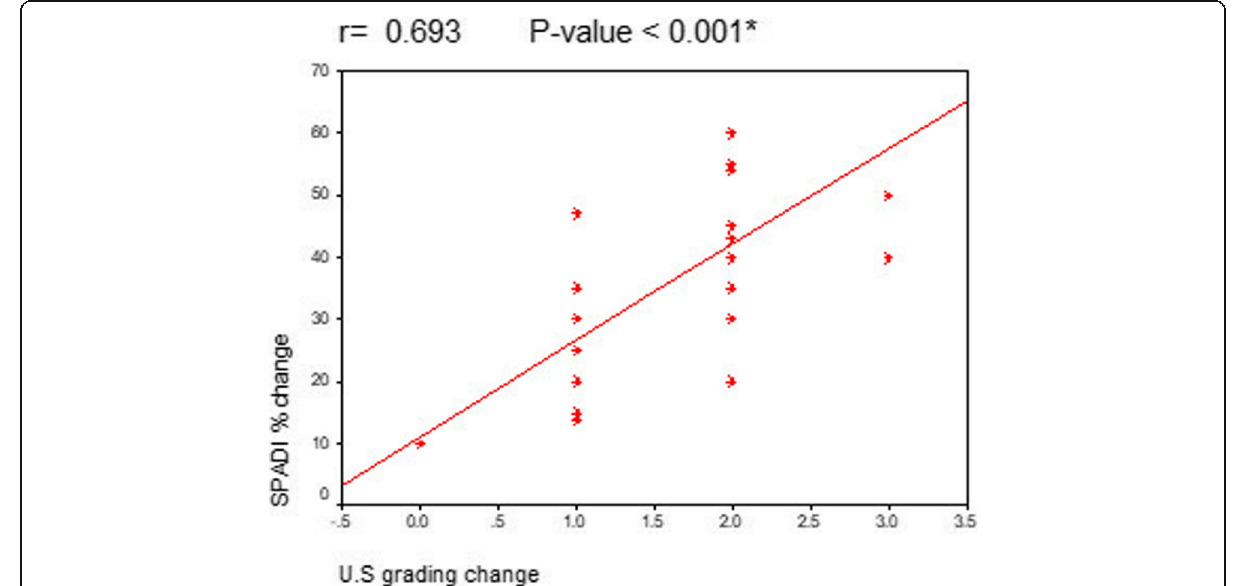
Fig. 4 Correlation between US grading change and SPADI